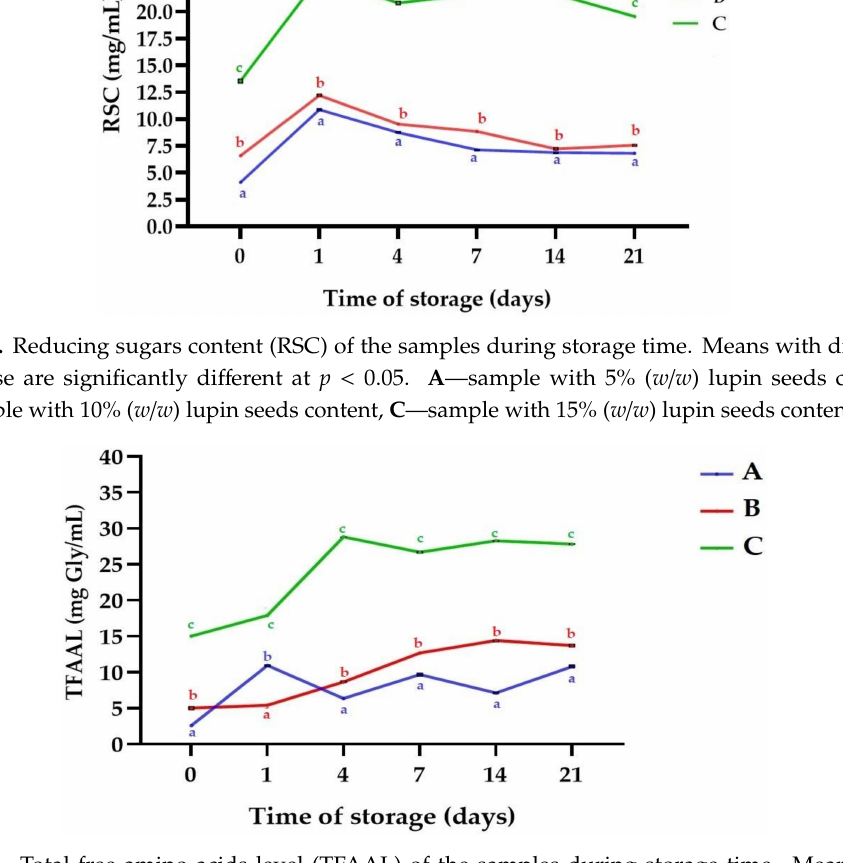
Figure 3. Total free amino acids level (TFAAL) of the samples during storage time. Means with di ff erent lowercase are significantly di ff erent at p < 0.05. A —sample with 5% ( w / w ) lupin seeds content, B —sample with 10% ( w / w ) lupin seeds content, C —sample with 15% ( w / w ) lupin seeds